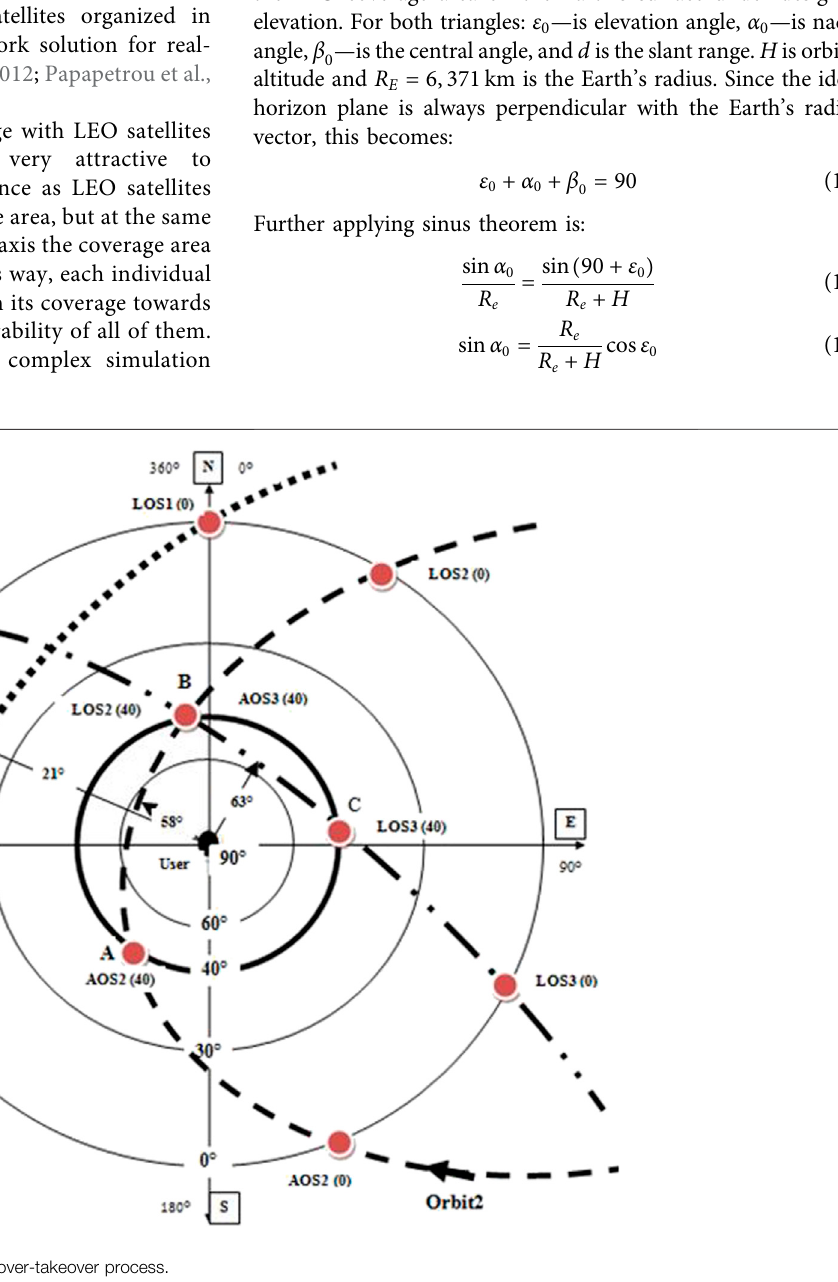
FIGURE 8 | Geometrical interpretation of the handover-takeover